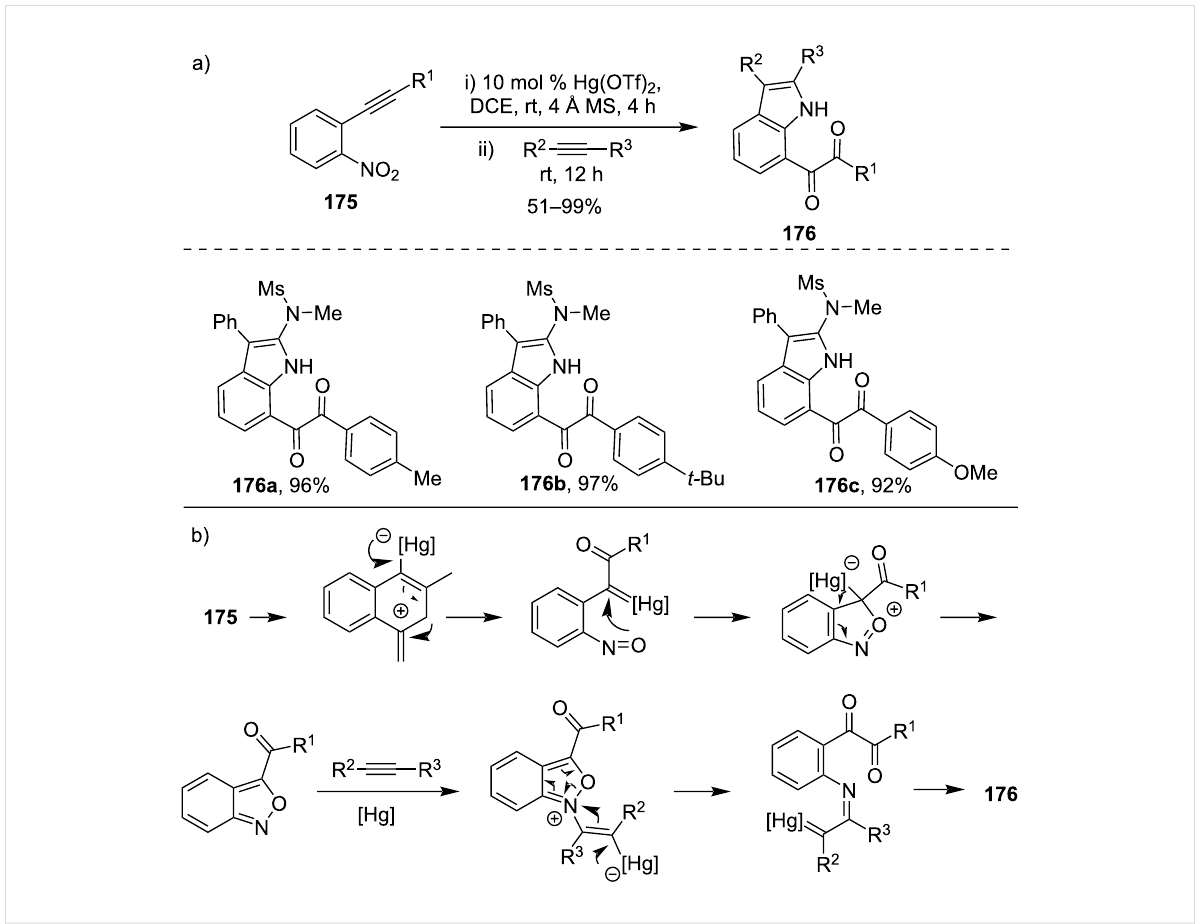
from the corresponding starting materials. For example, Zhang et al. showed that refluxing anilide 177 in presence of a catalyt- ic amount of Hg(OAc) 2 and 90% formic acid gave the tricyclic